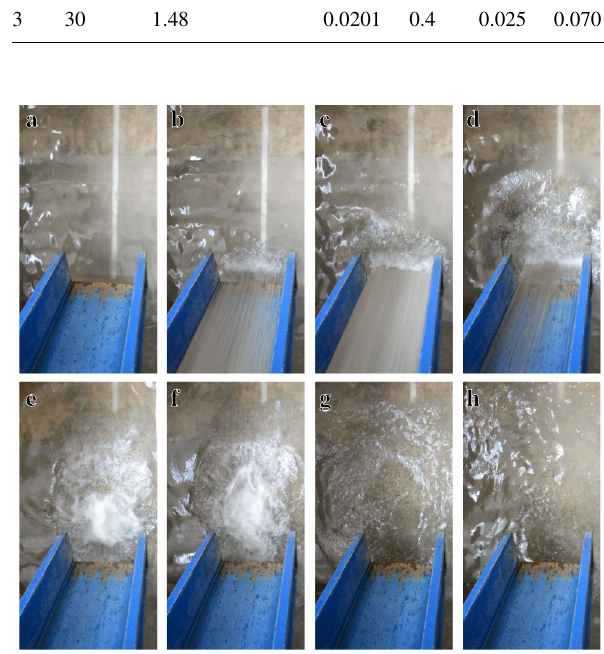
Fig. 3 Rock avalanche–debris flow sliding into the water. a the water surface is undisturbed prior to landslide entry; b the rock avalanche– debris flow begins to enter the water; c the primary body of the landslide enters the water and forms an obvious shock wave; d the landslide extrudes within the water and begins to move underwater; e almost the entire rock avalanche–debris flow has entered the water, and the shock wave continues to spread outward; f the underwater landslide reaches its maximum distance and stops; g when the shock wave thrusts away part of the water body, there is an obvious impact pit close to where the landslide entered the water; and h the nearby water backfills, and the sloshing caused by the landslide has been